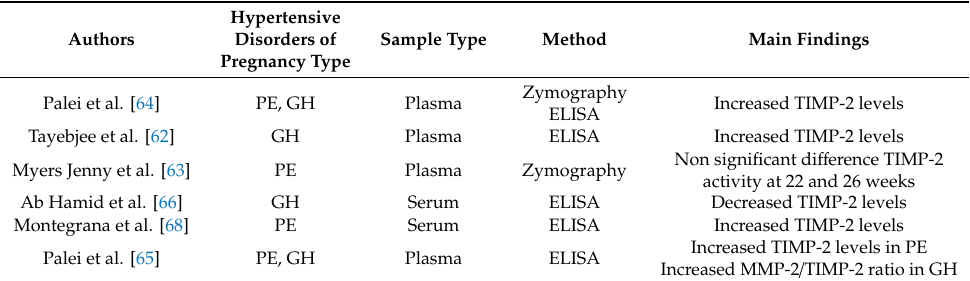
Table 3. Levels of tissue inhibitor of matrix metalloproteinase 2 (TIMP-2) in samples of patients with hypertensive disorders of